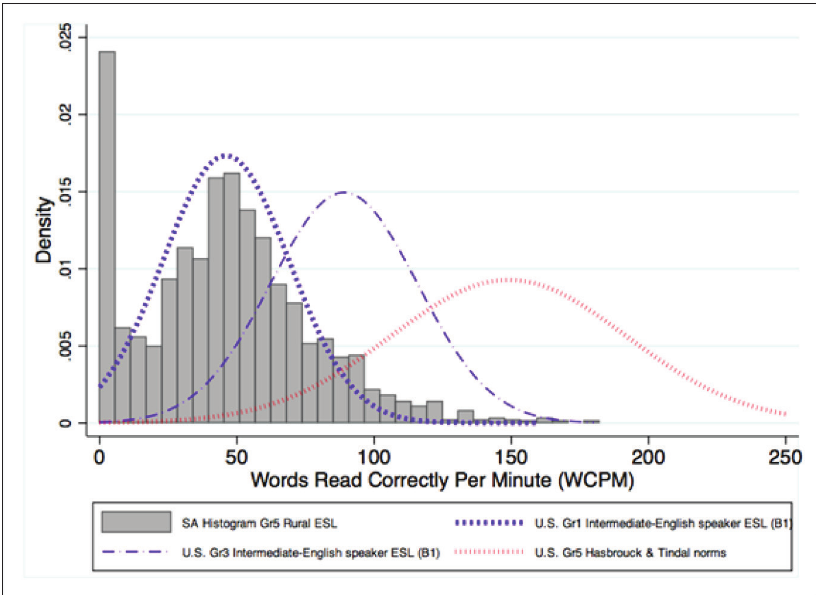
Figure 5: Distribution of ORF scores (WCPM) for rural South African ESL learners relative to Broward Country ESL learners (Source: Broward County